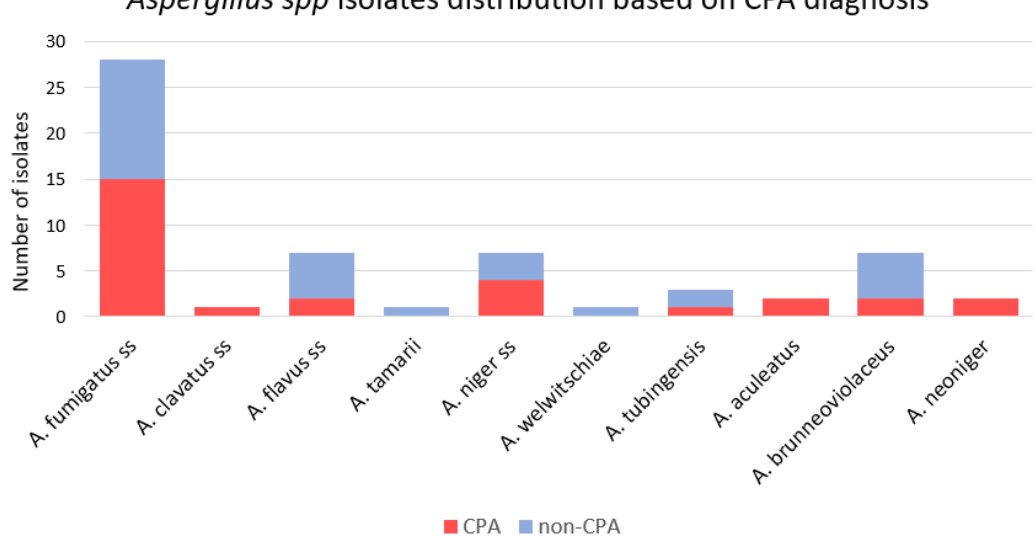
Figure 4. Aspergillus spp. isolates distribution based on chronic pulmonary aspergillosis (CPA) di- agnosis.